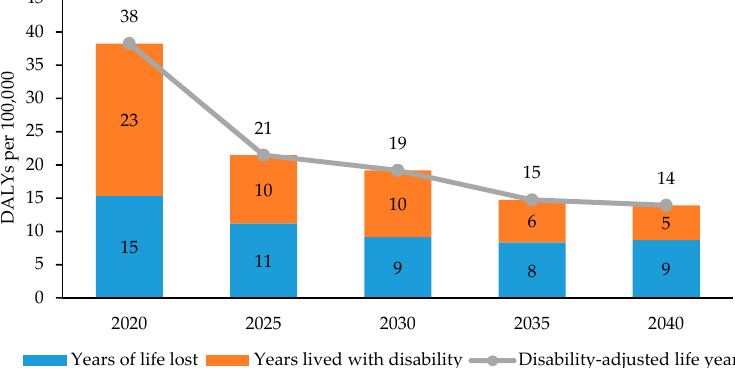
Figure 4. Projected years of life lost, years living with disability, and disability-adjusted life years due to tuberculosis in Korea, 2020–2040.